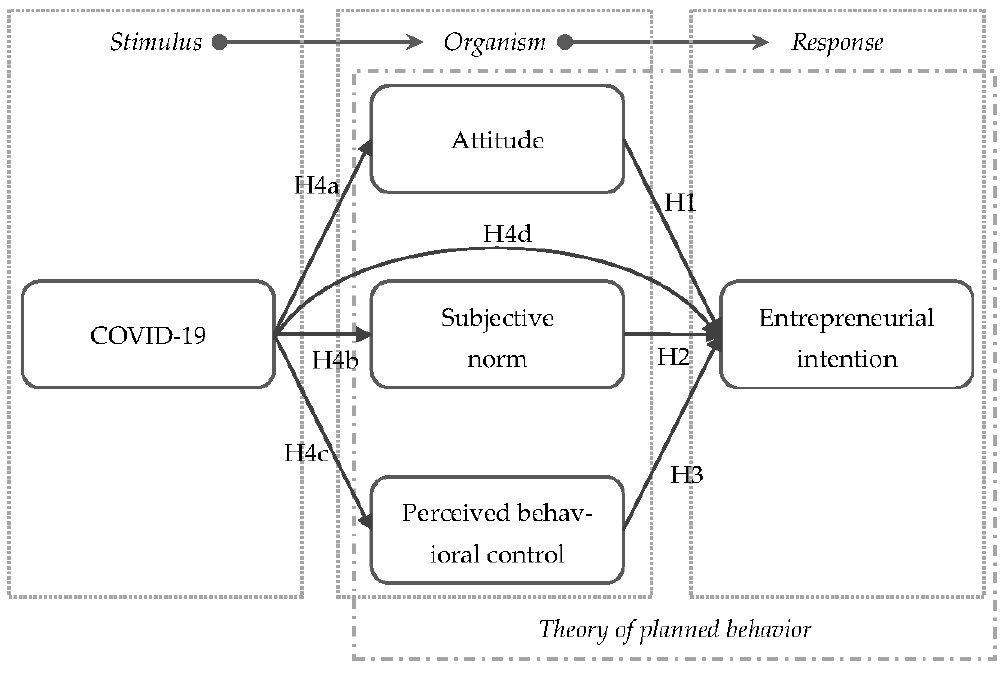
Figure 1. Conceptual framework and hypotheses.